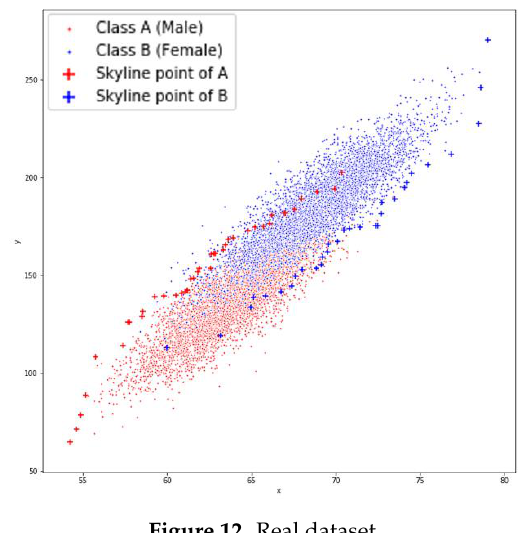
Figure 12. Real dataset. Table 24. Single skyline on the real dataset.